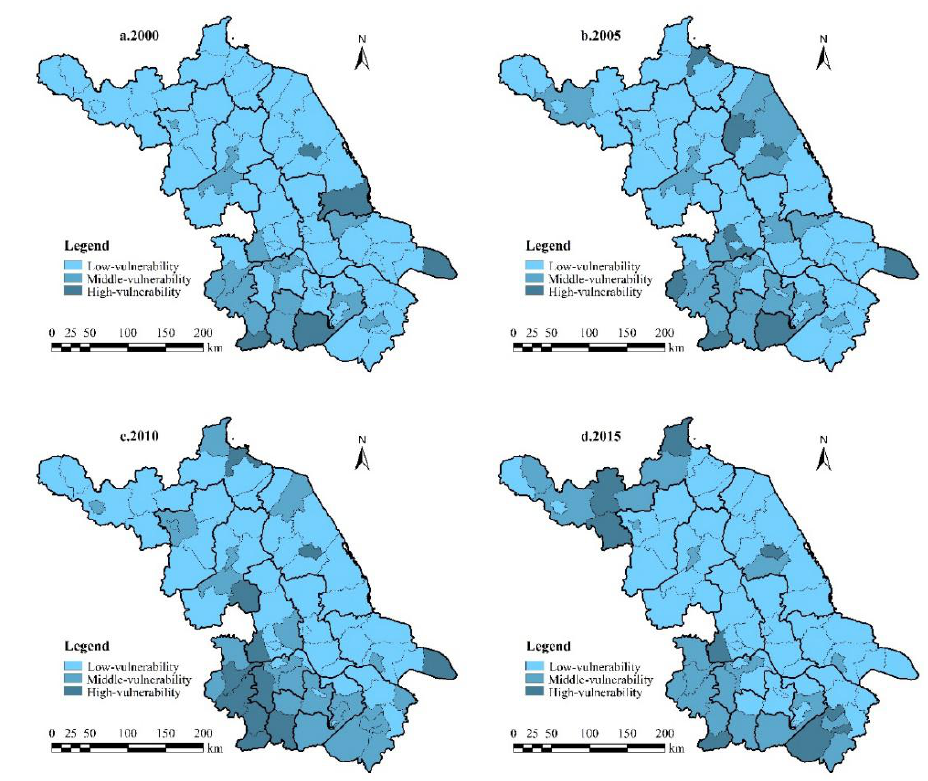
Figure 2. Spatial distribution of LVI in 2000, 2005, 2010, and 2015.